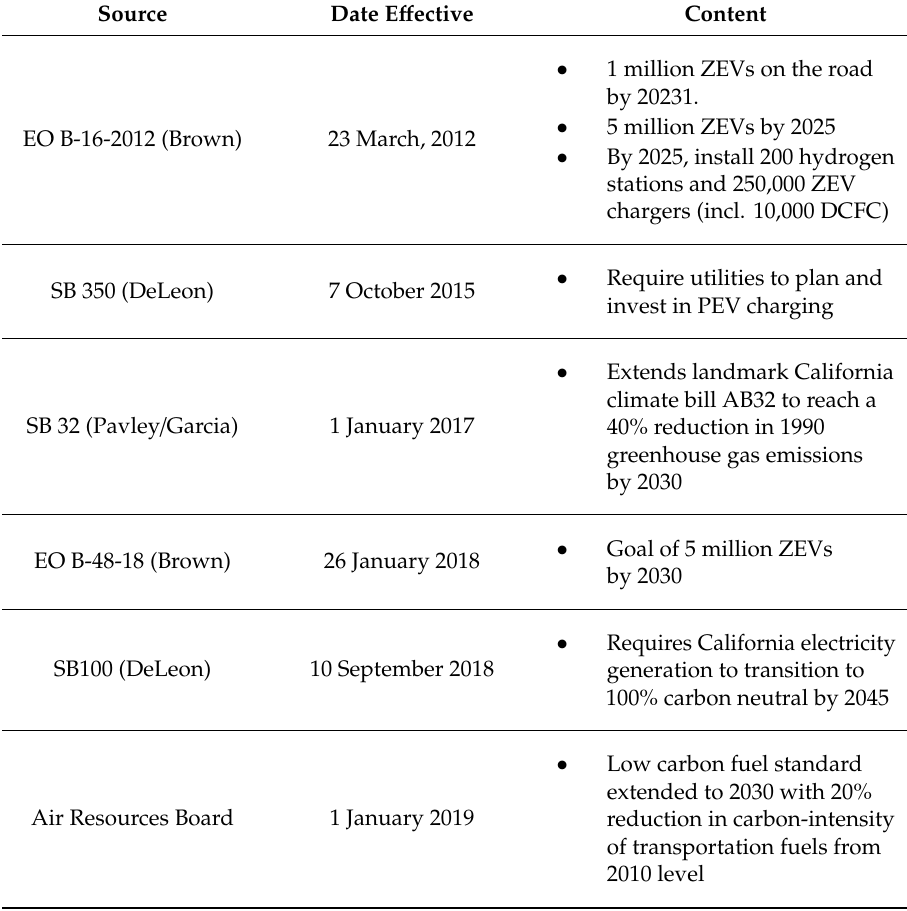
Table 1. California Transportation and Energy / Environmental Policy